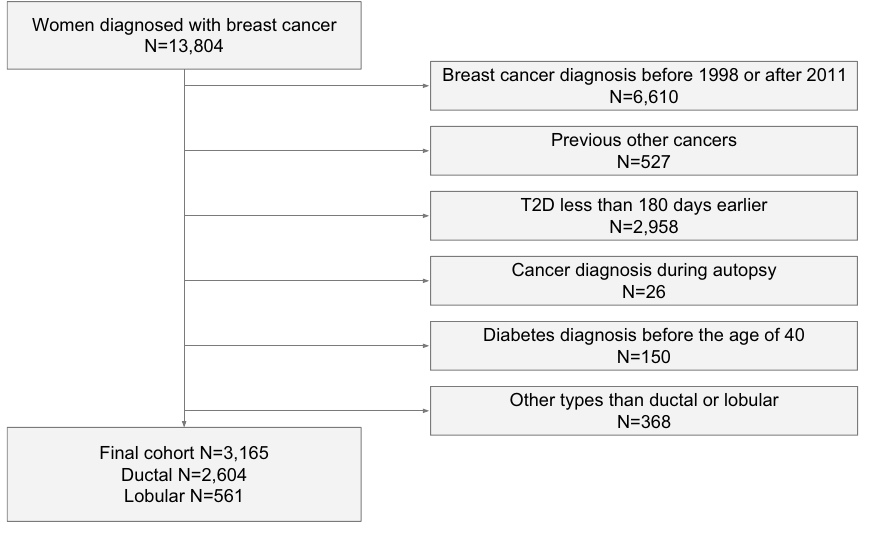
Figure 1. Cohort selection